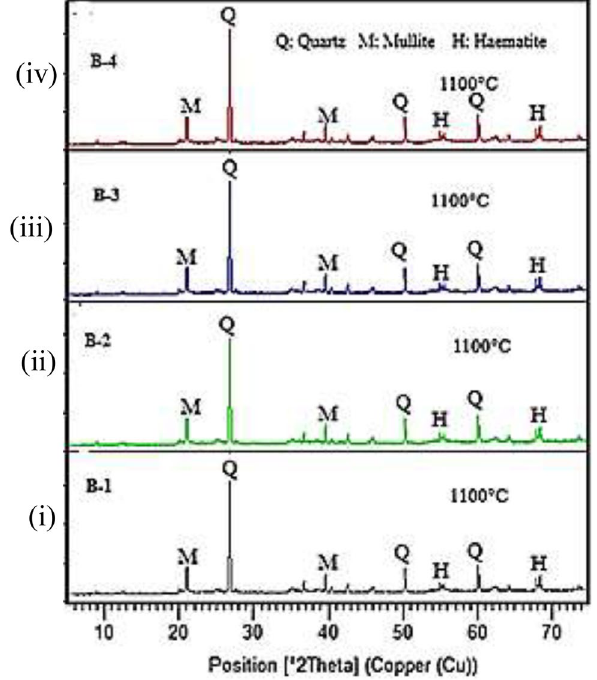
Fig. 8 The XRD peak patterns of clay bricks with (i) B-1 with 0 (ii) B-2 with 10 (iii) B-3 with 20 and (iv) B-4 with 30 wt% of granite pow- der sintered at 1100 °C for 2 h